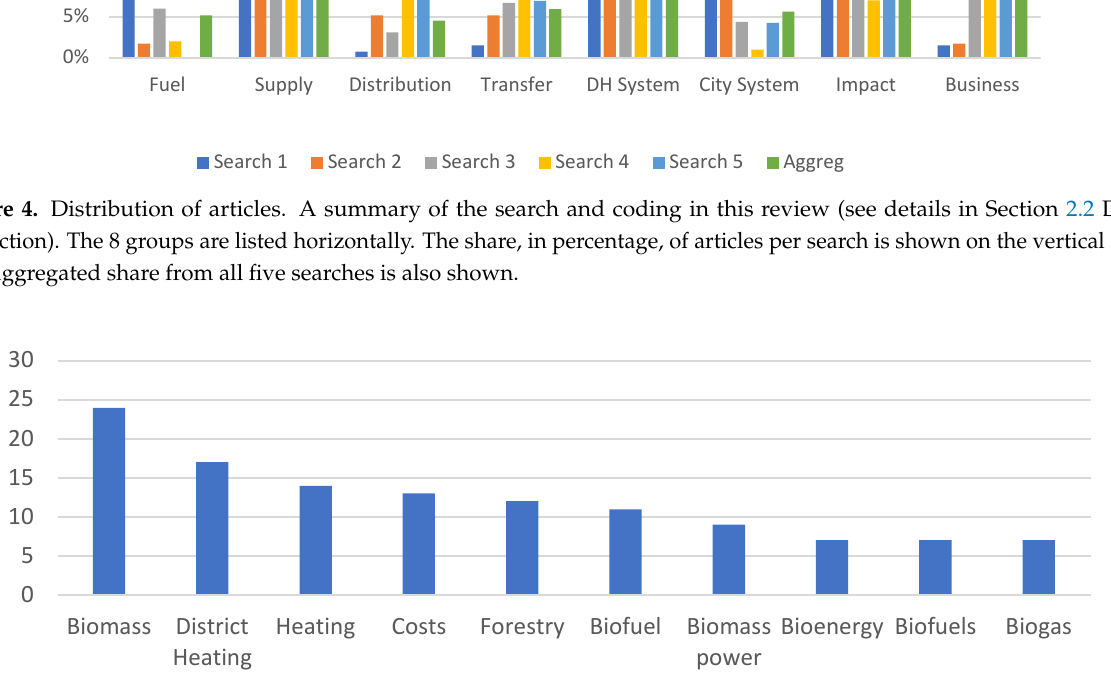
Figure 4. Distribution of articles. A summary of the search and coding in this review (see details in 2.2 Data Collection). The 8 groups are listed horizontally. The share, in percentage, of articles per search is shown on the vertical axis. The aggregated share from all five searches is also shown.